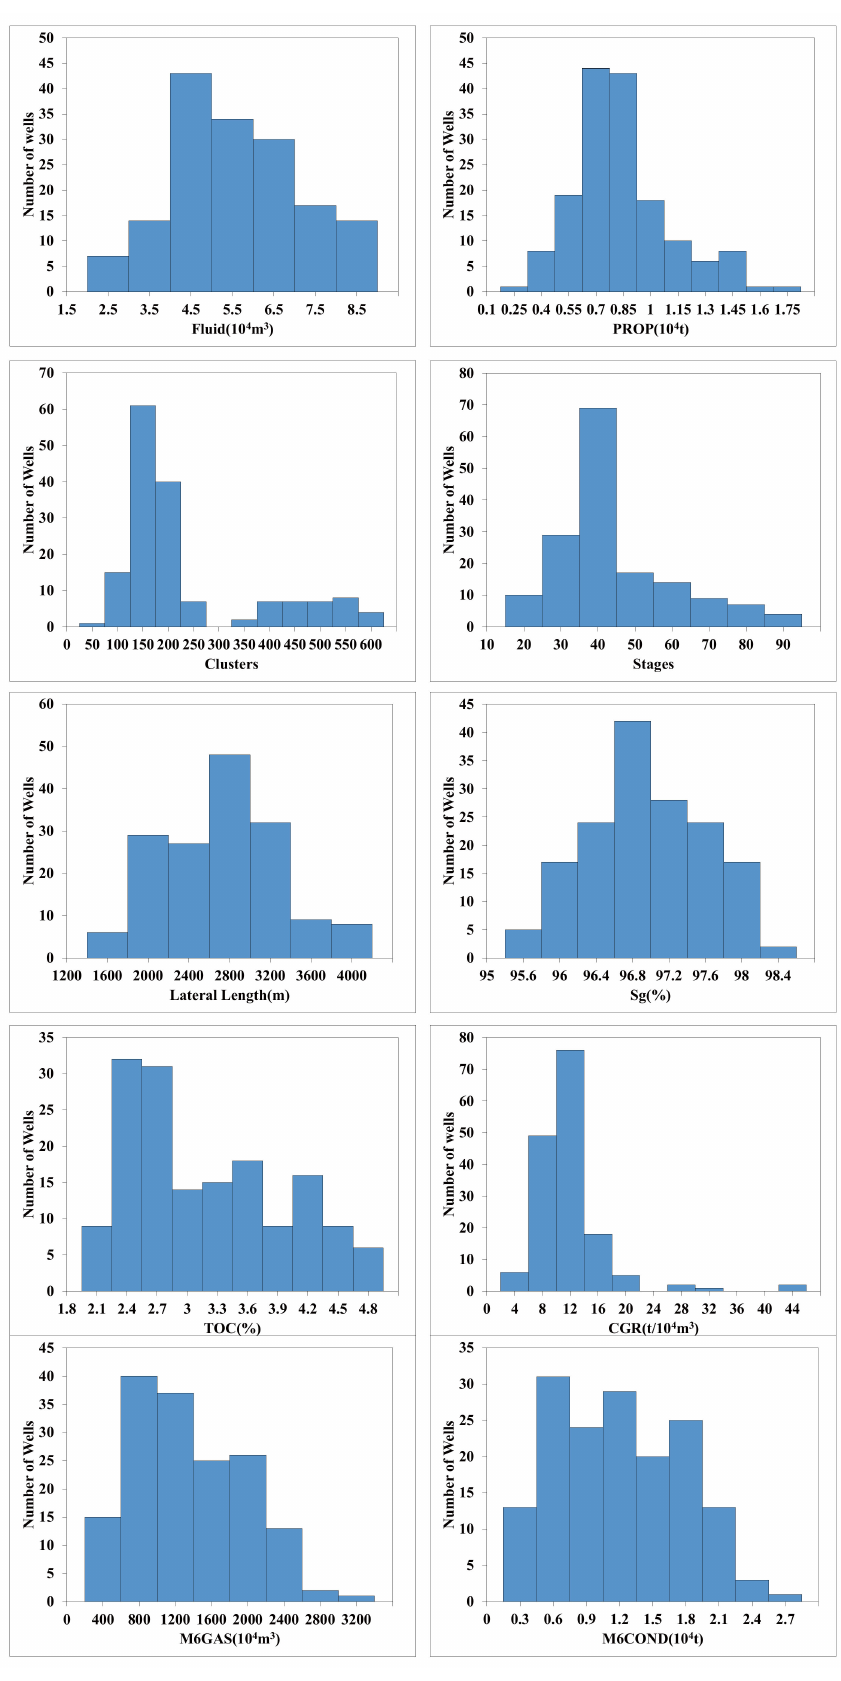
Figure 4. Histogram plots of all